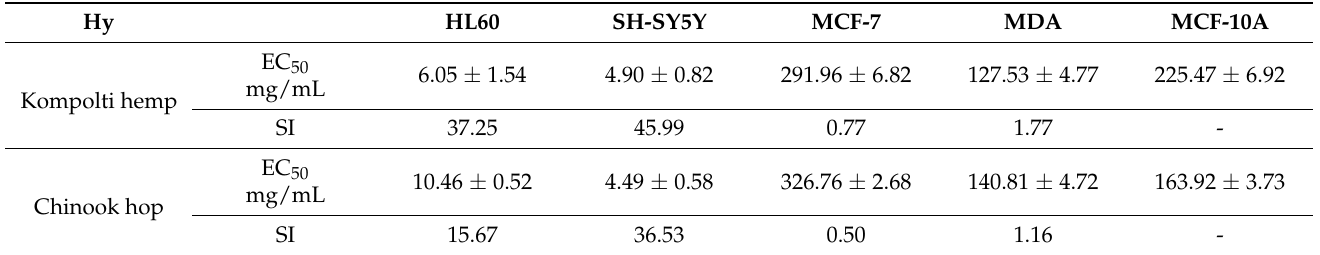
Table 4. EC 50 of Kompolti hemp and Chinook hop Hys obtained by dose-dependent MTT assay 48 h of treatments in human cancerous and non-cancerous cell lines. The values are expressed in mg/mL as mean ± standard error mean (sem). SI: Selectivity